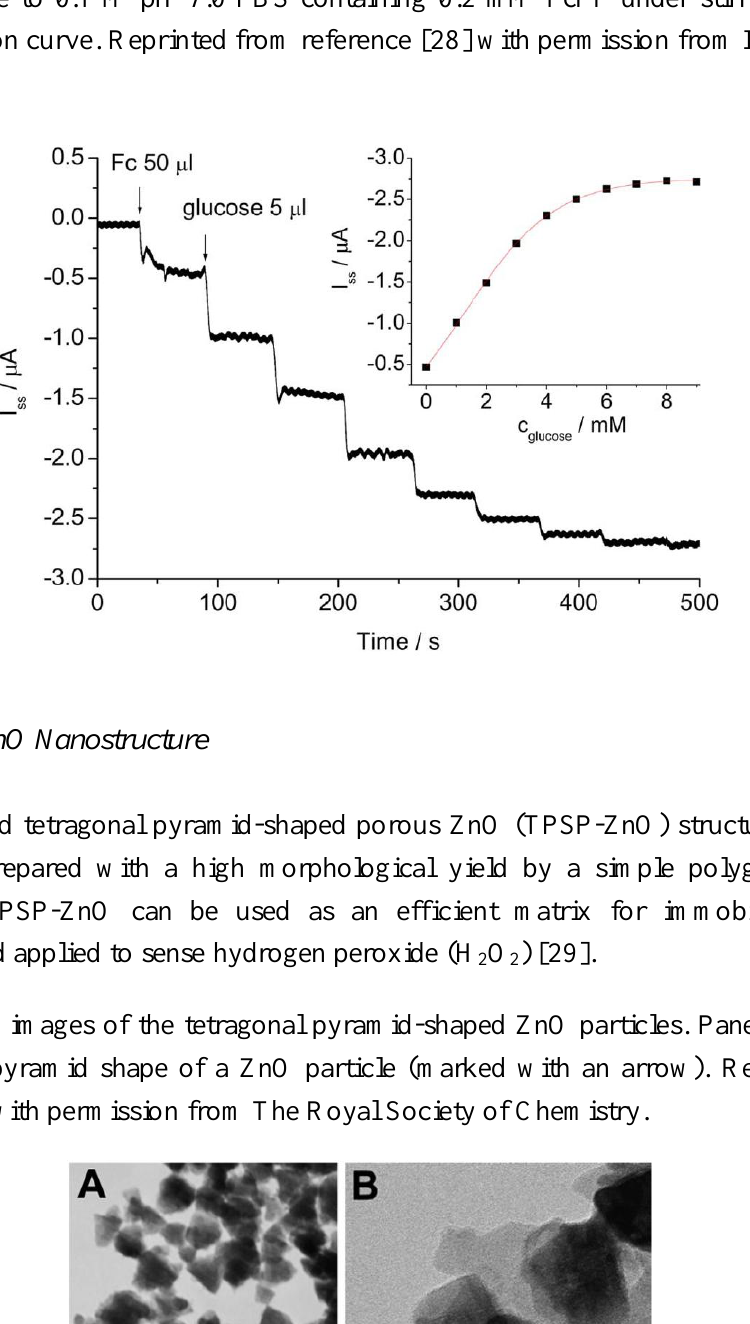
/Pt-PLL/PG by successive addition 2